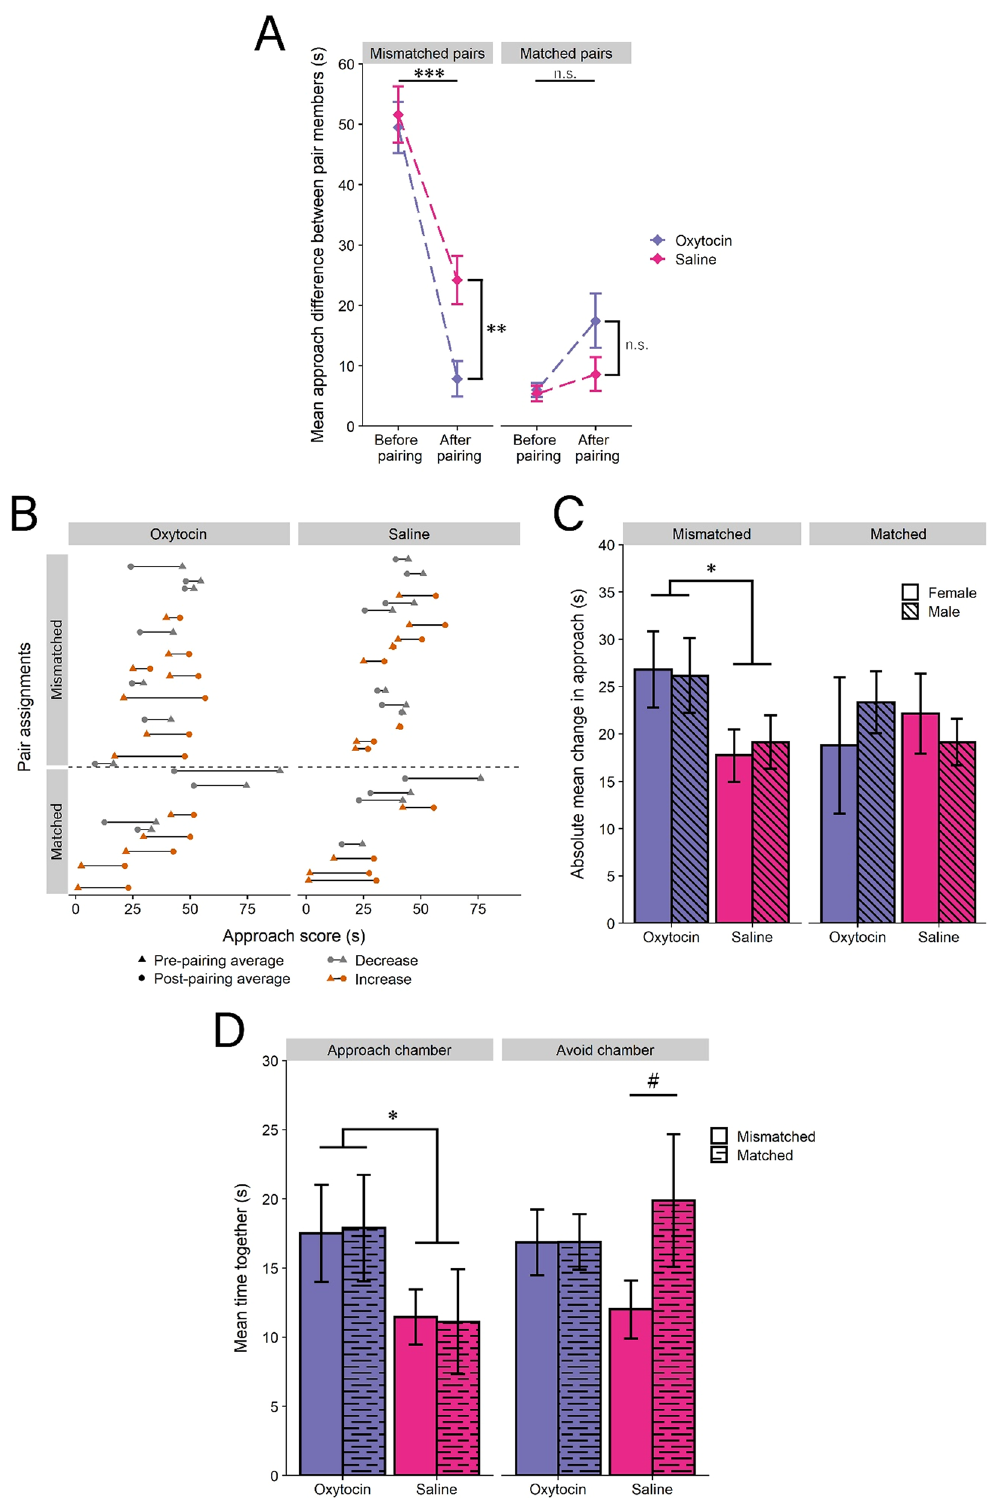
Figure 3. IN-OT drove mismatched pair mates to converge more in their social approach and pairs to increase their joint approach. ( A ) Mismatched pair mates became more matched, an effect enhanced by OT, while matched pairs remained matched and were unaffected by OT. ( B ) Within-pair average approach increased and decreased by pair for mismatched and matched OT and saline groups. C . Females and males of OT mismatched pairs changed their approach more than females and males of saline mismatched pairs. ( D ) IN-OT increased the amount of time OT pair mates spent together in the approach chamber. (n.s. = not significant; # = p < 0.10; * = p < 0.05; ** = p < 0.01; *** = p < 0.001). Error bars are ±